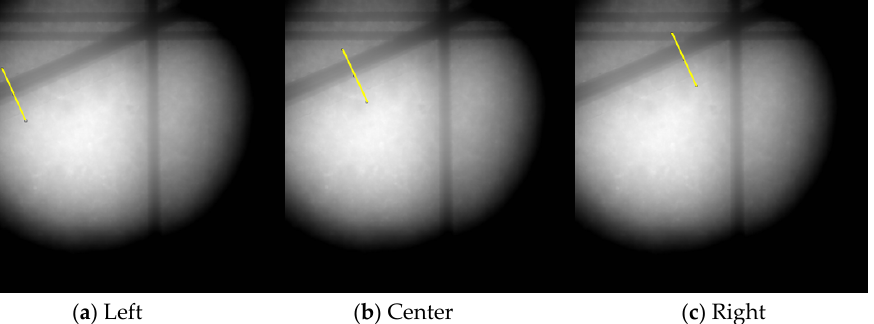
Figure 27. X-ray images of filled grout for 200 mm thick PC bridge taken by the 950 keV source. ( a ) Left; ( b ) center; ( c ) right. Line segments for gray value analysis are also indicated.